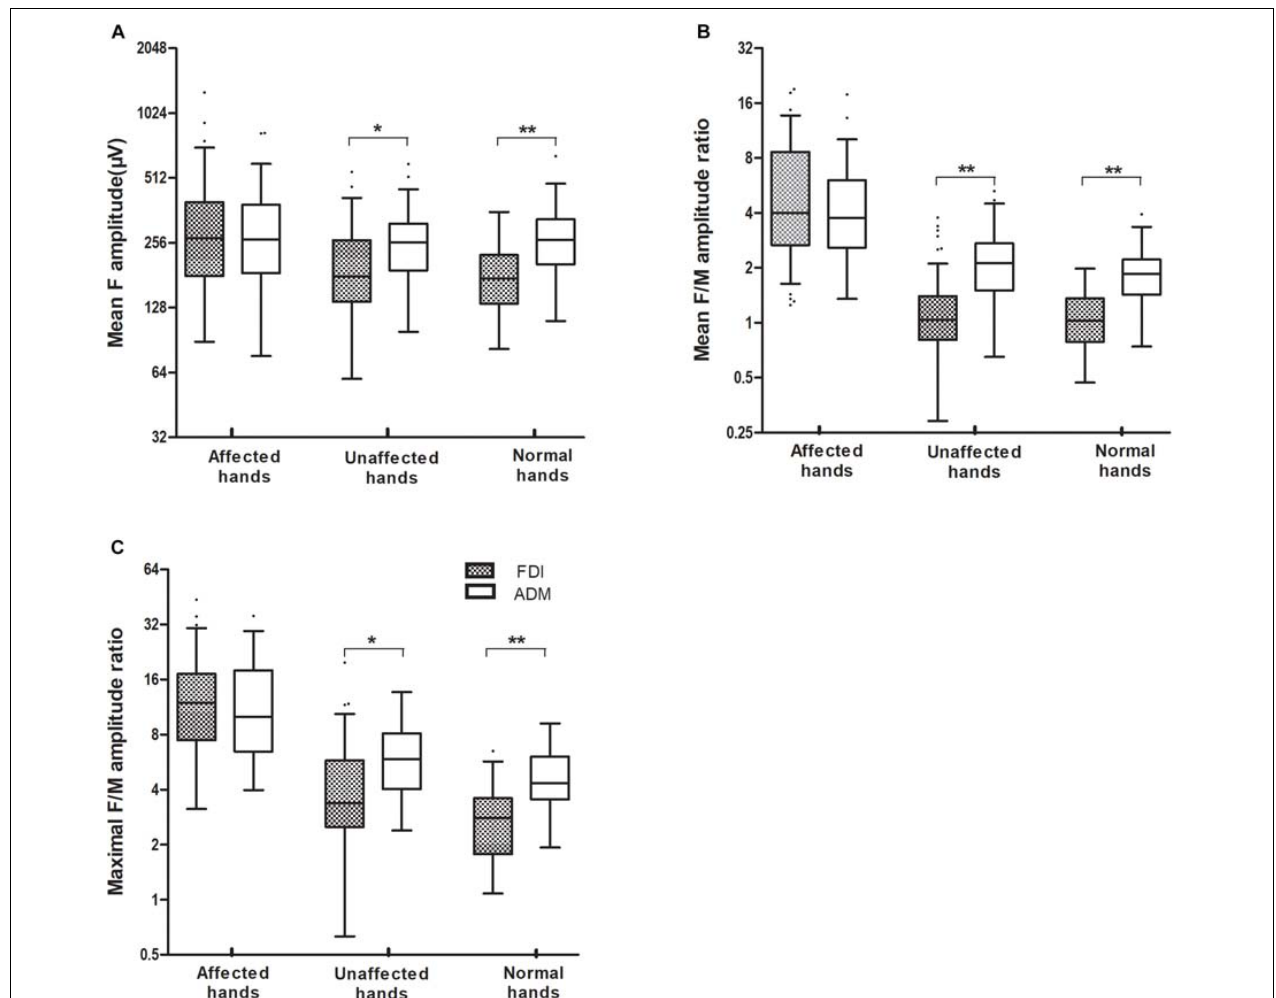
FIGURE 1 | The mean F-wave amplitude (A) , and the mean and maximal F/M amplitude ratios (B,C) , recorded over the FDI and ADM muscles were significantly increased in ALS patients with affected hands compared with those with unaffected hands. When the FDI and ADM were compared in HCs and the unaffected hand group, the FDI showed a noticeably lower mean F-wave amplitude, and a lower mean and maximal F/M amplitude ratios, than for the ADM. By contrast, there were no differences in F-wave measurements between the FDI and ADM in the affected hand group. ∗∗ P < 0.001; ∗ P < 0.05. The numerical data on the Y-axis were logarithmically transformed